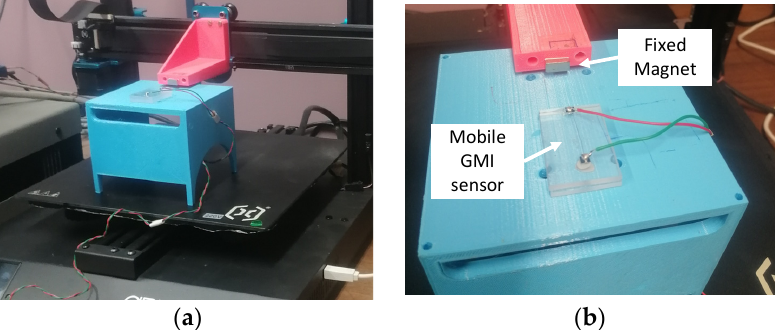
Figure 8. Photographs of the GMI sensor experimental setup: ( a ) general view of the sensor and magnet installation on the 3D printer motor; and ( b ) detail of the fixed neodymium magnet and the mobile GMI sensor.